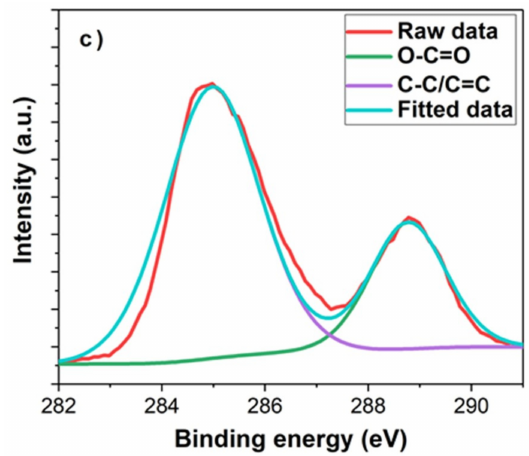
Figure 2. ( a ) FTIR of two types of GQDs. ( b ) XPS survey spectra for GQDs-COOH and GQDs-NH2. ( c ) The high resolution deconvoluted C 1s spectra for GQDs-COOH.